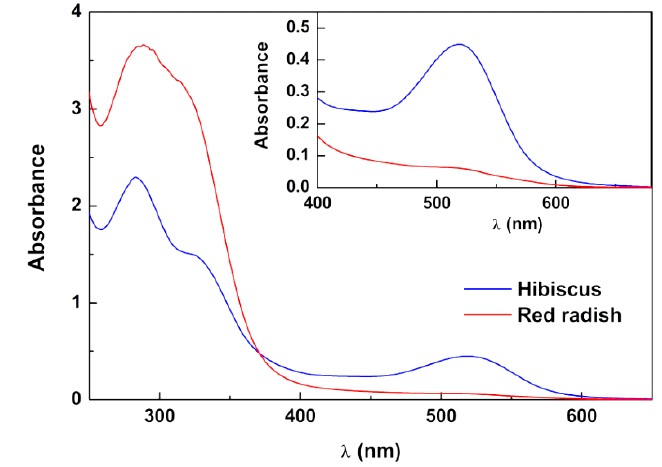
Figure 1. Absorption spectra of aqueous solutions of lyophilized extracts of red radish (concentration: 1.47 × 10 − 3 g/mL) and hibiscus (concentration: 1.73 × 10 − 3 g/mL). Inset: Expansion of the spectra in the visible region.